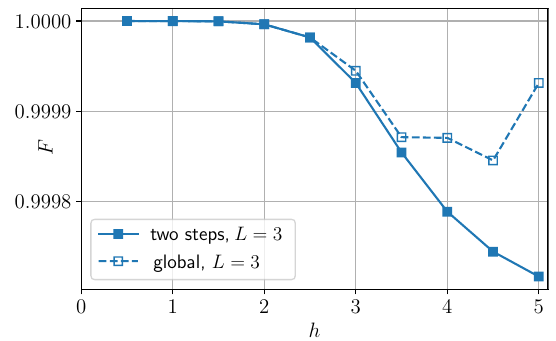
FIG. 13. Comparison of the accuracy with respect to the mag- netic coupling h between global optimization (open squares) and the two-step approach (filled squares) described in the text. The data refer to P = 6 and | ψ 0 (cid:3) = | (cid:5) E (cid:3)